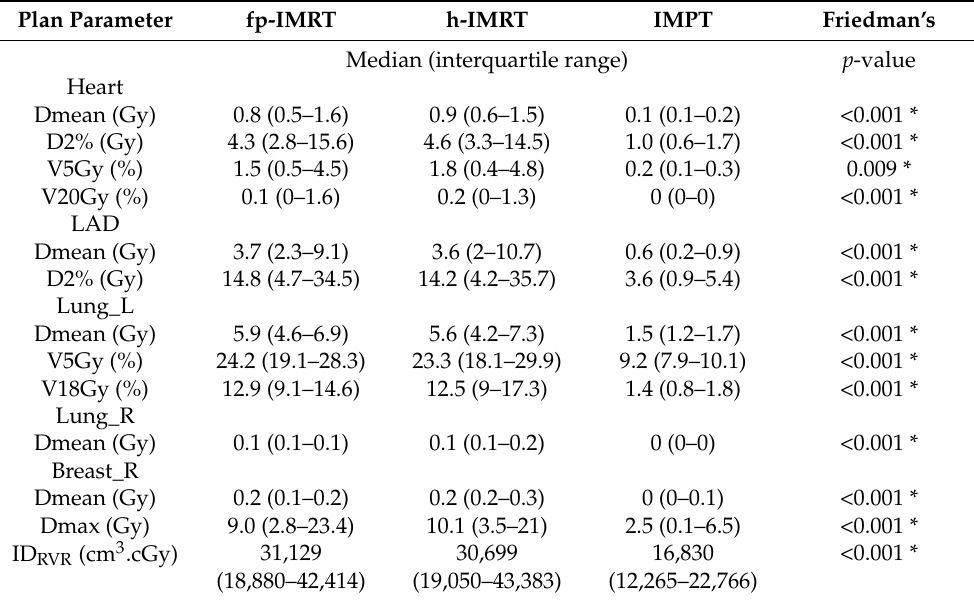
Table 3. Differences in organ at risk parameters between fp-IMRT, h-IMRT, and IMPT plans, n = 16.